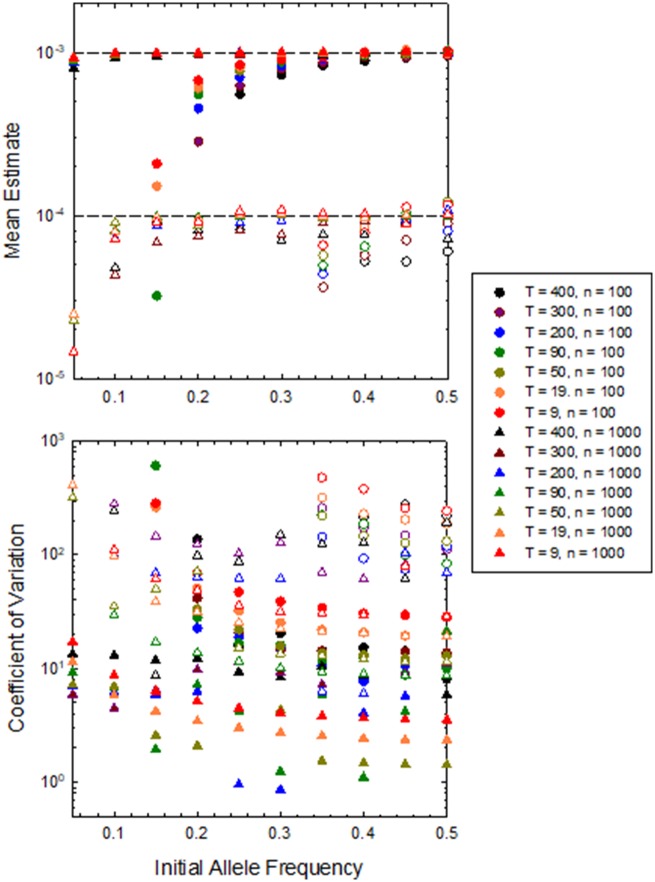
—Mean and CV of estimates of σs2 for series of samples taken at T + 1 consecutive time points, each involving sample sizes of n = 100 or 1,000 diploid genomes. Results are given for a range of initial allele frequencies, each based on 106 simulations with an effective population size of 108 individuals, ensuring essentially no genetic drift on the time scale of the analyses, and mean selection coefficient μs=0.0. Closed points refer to situations in which σs2=10−3, whereas open points are for σs2=10−4. Data points are excluded for some cases at low allele frequencies where the mean estimates of σs2 were negative.